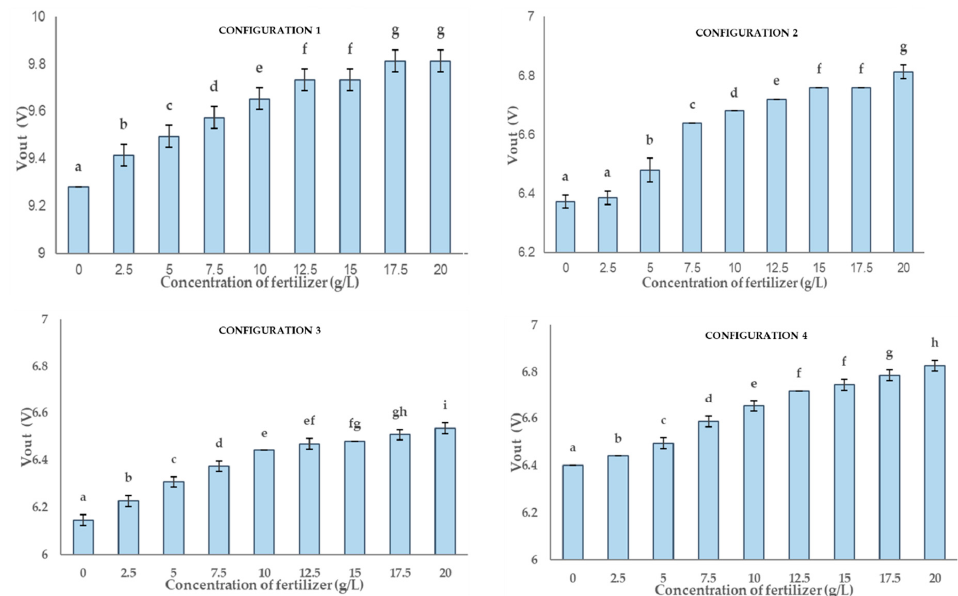
Figure 13. The graph presents a multi-range analysis for the four configurations where they are drawn by columns. Each column contains non-significant values between them. The different letters show that the values are statistically significant. In each column the vertical bar on it represents the standard deviation.